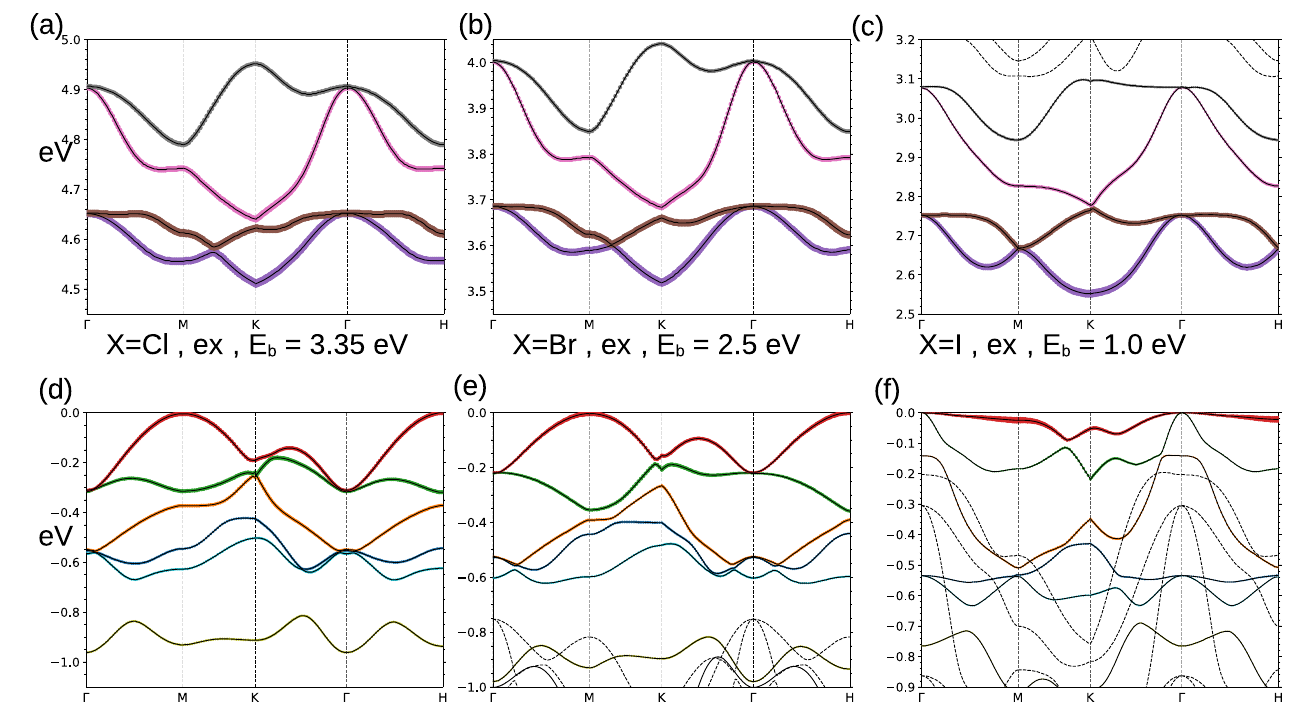
Fig. 6 Spectral weight analysis in the band basis for the excitons in bulk CrCl 3 , CrBr 3 , CrI 3 . The spectral weight analysis for the deepest lying exciton ex 1 in each case; ( a , d ) for CrCl 3 , ( b , e ) for CrBr 3 and ( c , f ) for CrI 3 . The spectral weight is raised to the fourth power to identify variations in the band contribution to the spectral weight. In the direction of Cl → Br → I the number of bands that contribute to the spectral weight of ex 1 decreases. Also the exciton spectral weight becomes more localized in band basis for X = I, compared to X = Cl,